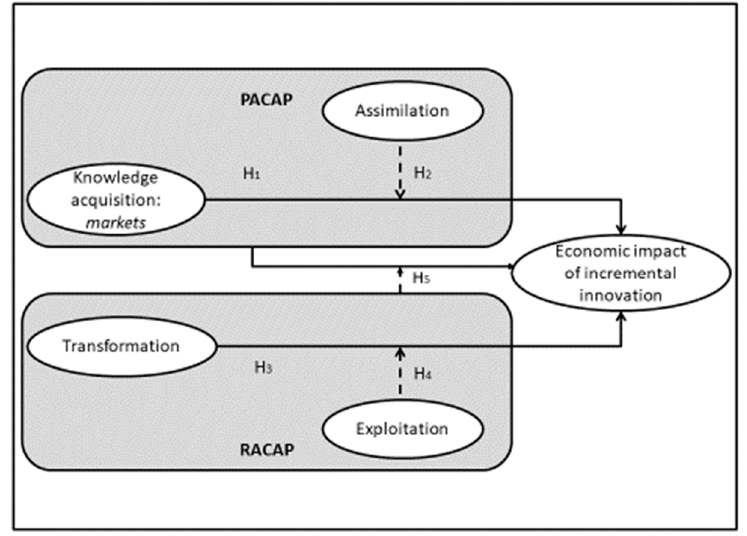
Figure 1. Model of Figure 1. Model of analysis.